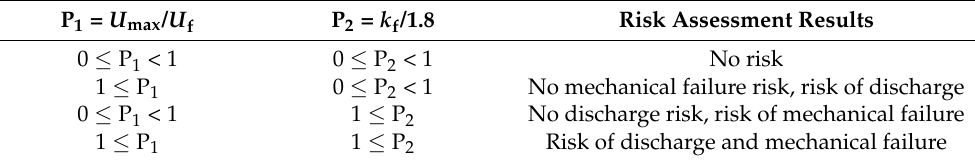
Table 1. Transmission line risk assessment in the case of